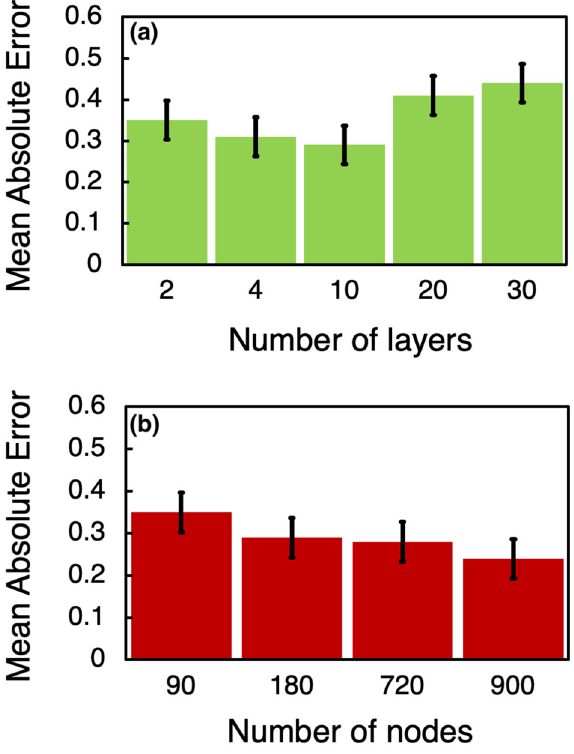
Fig. 2 The in fl uence of neural network size to prediction accuracy. The effect of neural network shape on the accuracy of the DL model. All model training was run until the mean absolute error (MAE) is converged. The change in MAE with respect to the number of hidden layers ( a ) and the effect of number of nodes per layer to MEA of the trained model ( b ). The error bars were calculated training each model on the same data with ten repetitions. The error bars represent standard deviation (s.d.). The training data output values (i.e., property values) are standardized to have a mean of zero and a standard deviation of